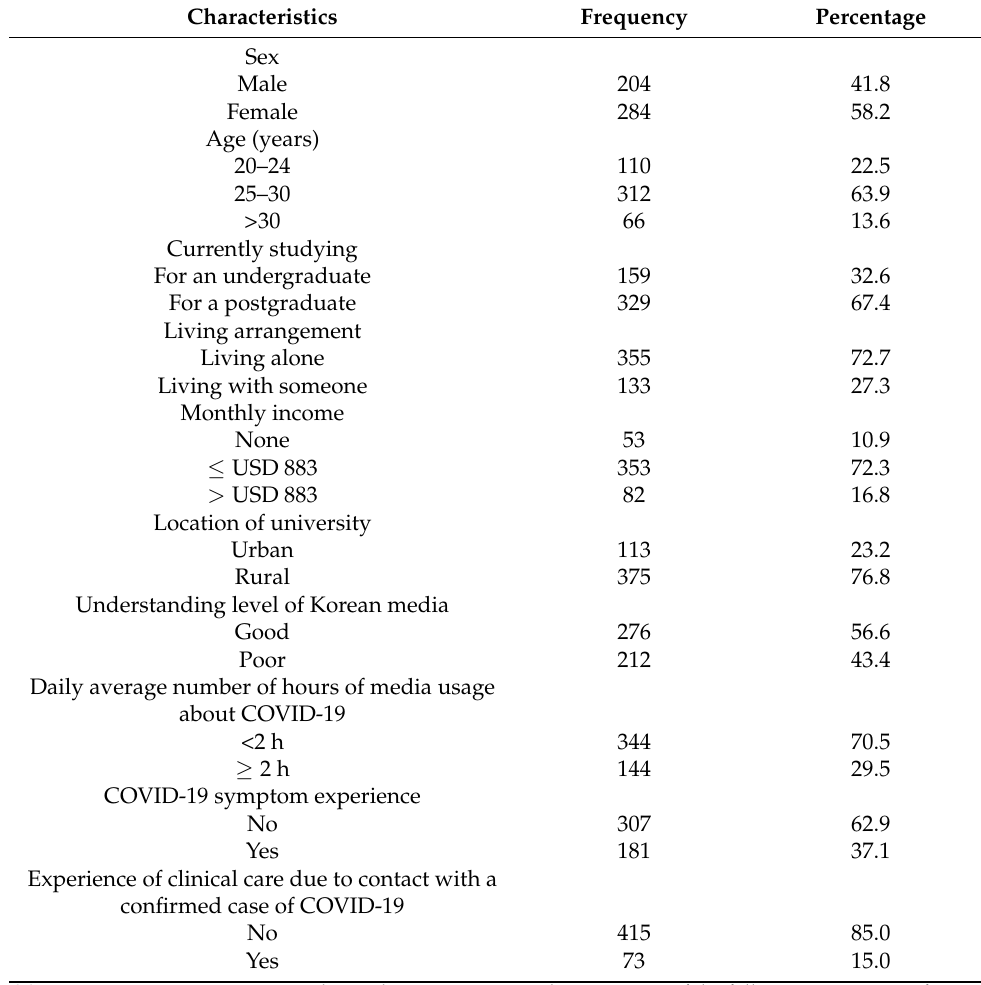
Table 1. Frequencies of general characteristic variables ( N = 488).